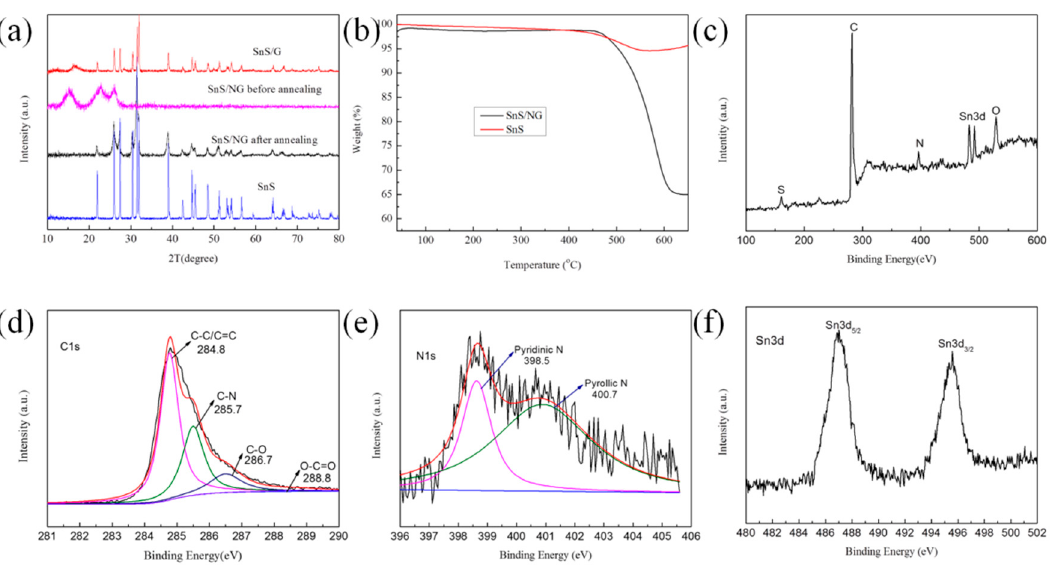
Figure 2. ( a ) X-ray diffraction (XRD) patterns of SnS, SnS/graphene (SnS/G), and SnS/NG before and after heat treatment; ( b ) thermo-gravimetric analysis (TGA) curve of the SnS / NG and SnS hybrid in air; ( c ) survey X-ray photoelectron spectrometer (XPS) spectra; and high-resolution XPS spectra of ( d ) C 1s, ( e ) N 1s and ( f ) Sn 3d of SnS /